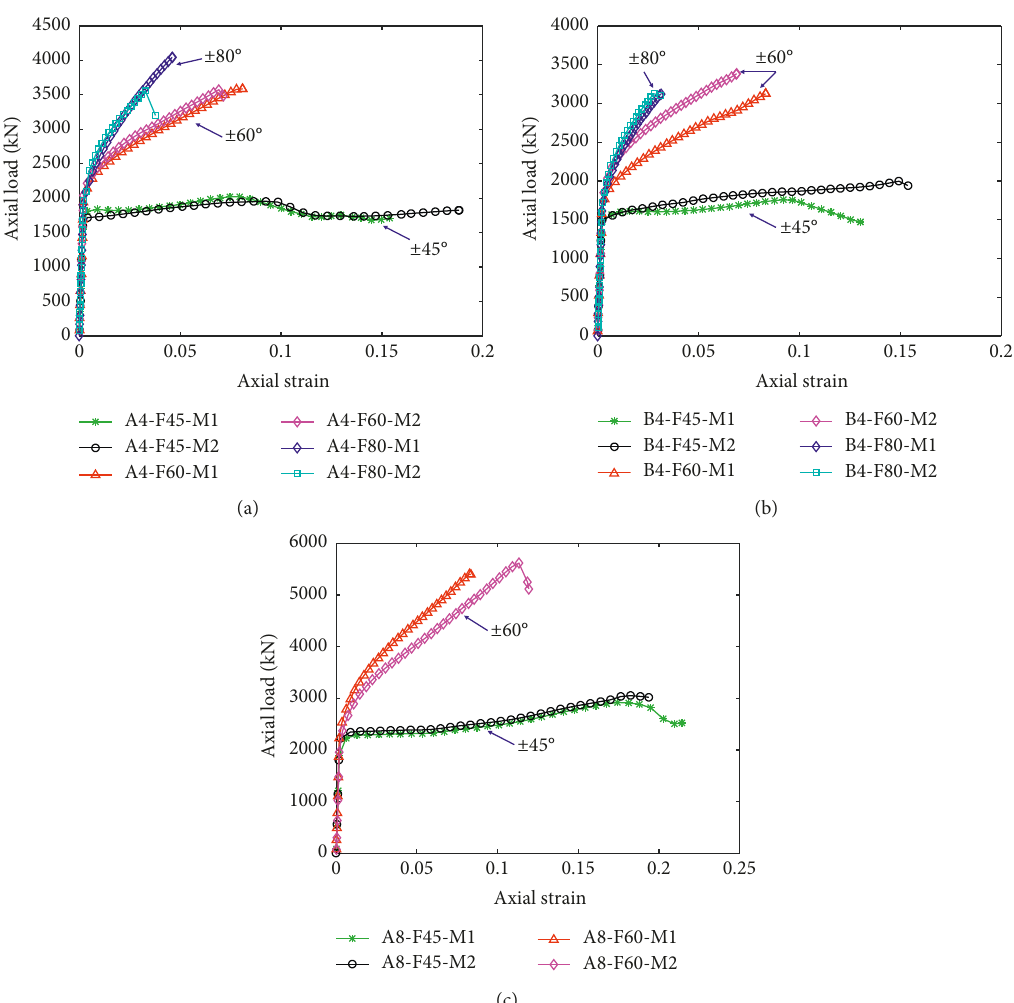
Figure 14: Effect of fiber orientations. (a) t